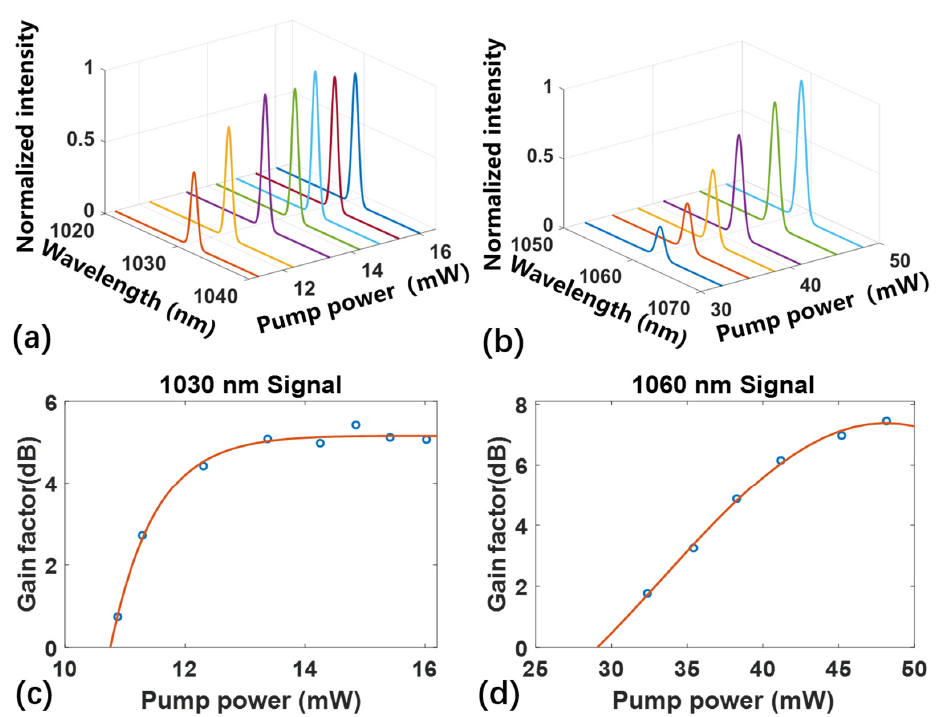
Figure 5. Gain characterization of the Yb 3+ -doped LN waveguides. Measured signal spectra as a function of increasing pump powers measured at ( a ) 1030 nm and ( b ) 1060 nm. Measured net internal gain as a function of increasing pump powers at different signal wavelength ( c ) 1030 nm and ( d ) 1060 nm.